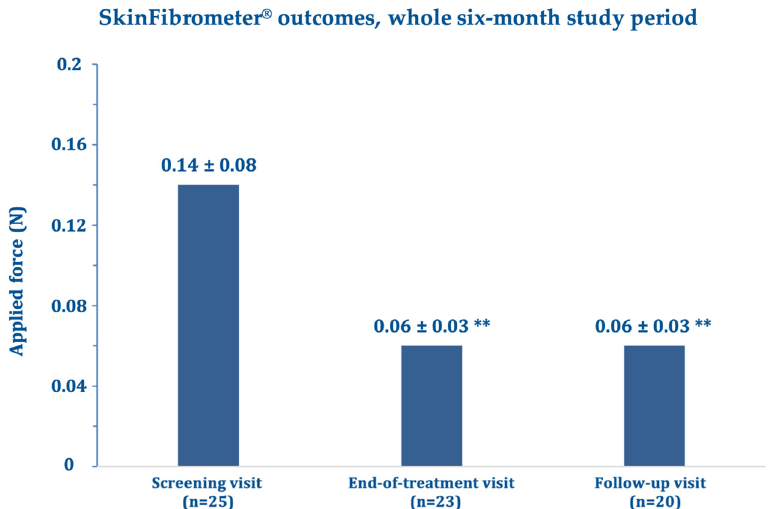
Figure 4. Mean changes ± standard deviation in the force applied to the target lesion area after 90 days (end-of-treatment visit) and 180 days (follow-up visit) vs. baseline (screening visit); applied forces measured in Newton (N). ** p <0.0001 vs. screening visit.